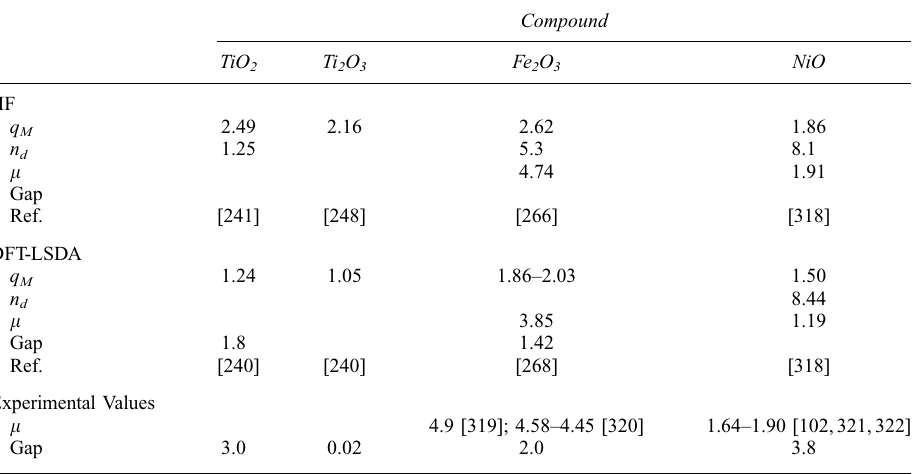
TABLE XI Comparison of Electronic Properties for 3 d -metal Oxides: Net Charges ( q M ), Number Electrons in the Md Shell ( n d ), Spin Moments ( m ) and Band Gap (eV).